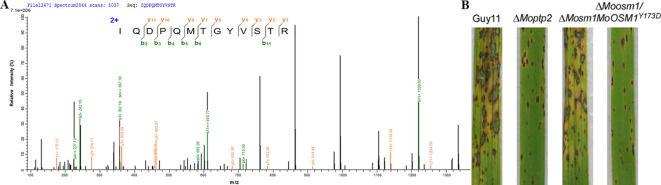
Hyperphosphorylation on MoOsm1 Tyr173 causes virulence defect in M. oryzae.(A) MoOsm1 phosphopeptide (QDPQMTGYVSTR) in the ΔMoptp2/MoOSM1-GFP strain was identified by mass spectrometer analysis and the phosphorylated sites were Tyr-173. (B) The pathogenicity assay on rice leaves. Conidial suspensions of strains were sprayed onto two-week-old rice seedlings (CO-39). Diseased leaves were photographed after 7 days of inoculation.